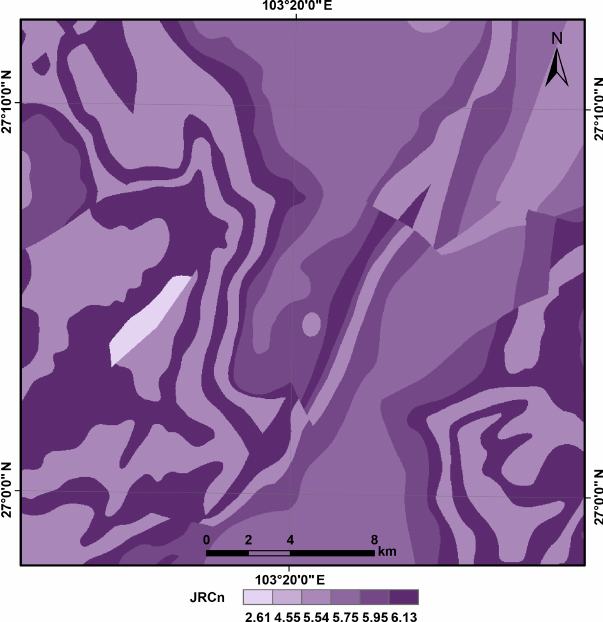
Figure 8. JRC n component of shear strength assigned to rock types in the study